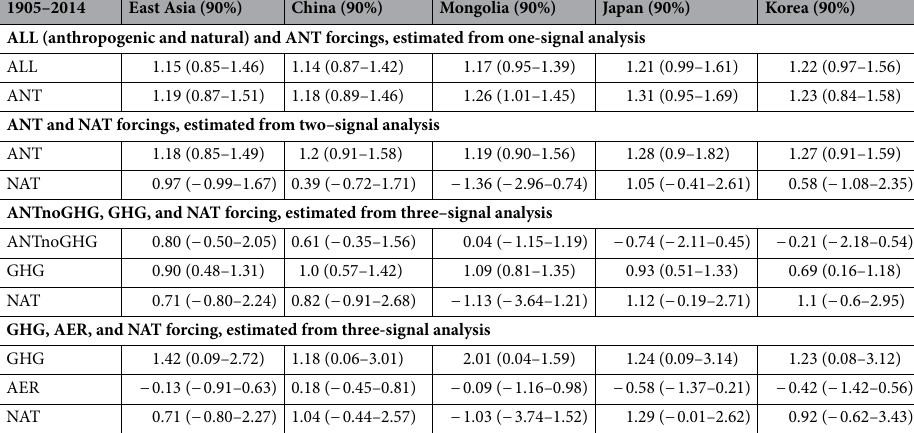
1905–2014 East Asia (90%) China (90%) Mongolia (90%) Japan (90%) Korea